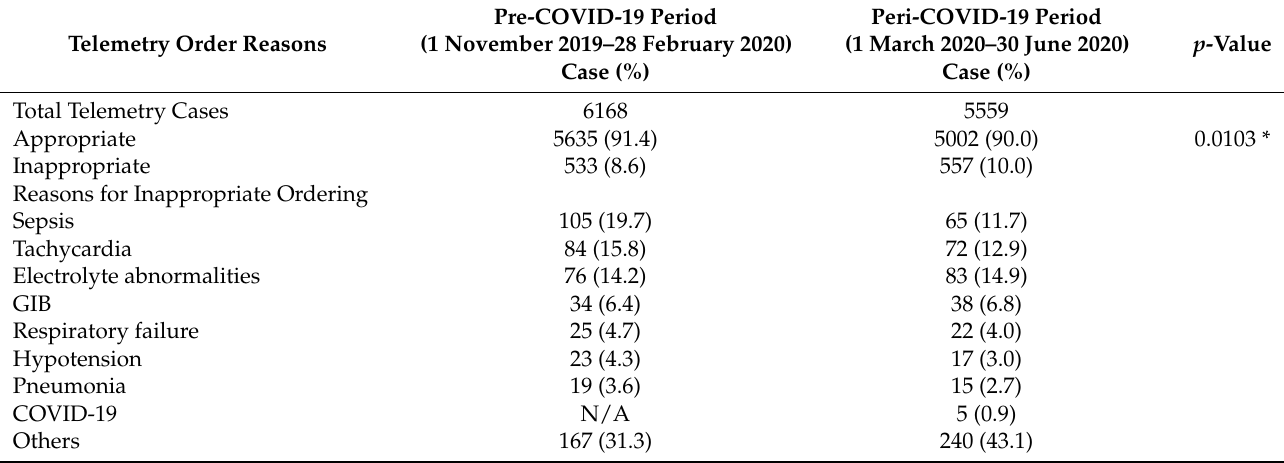
Table 1. The list of inappropriate telemetry order reasons and their frequency during the pre-COVID-19 and the peri- COVID-19